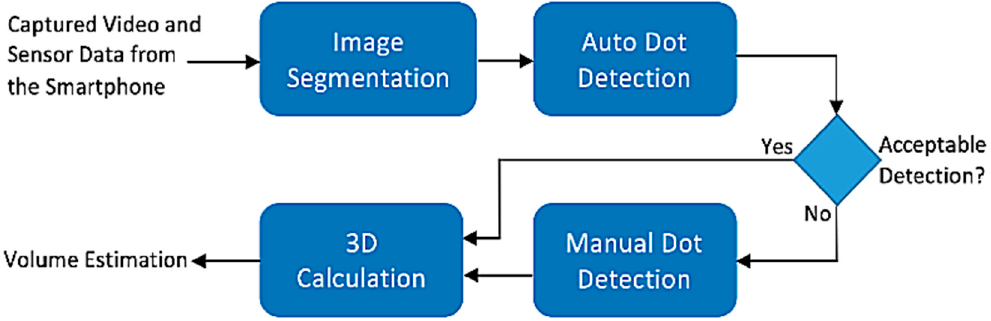
Figure 3. The DDRS volume calculation software, which shows the higher-level architecture of the algorithm. The algorithm uses the extracted frames and motion sensor data to isolate the image, calculate depth, and finally reconstruct a 3D model. calculate depth, and finally reconstruct a 3D